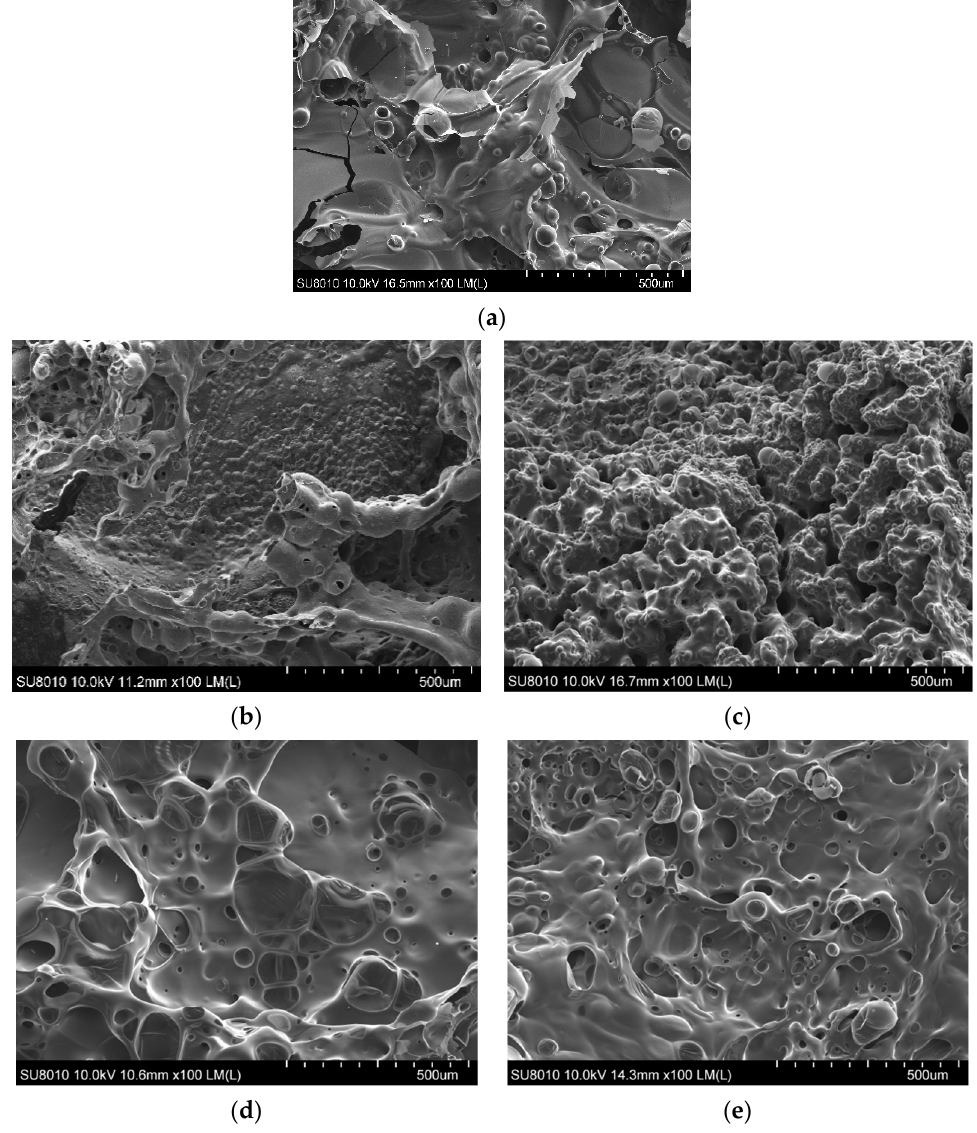
Figure 4. SEM images of remnants from the combustion process, ( a ) Ep5, ( b ) 5M, ( c ) 5A, ( d ) 5B, ( e ) 5F.